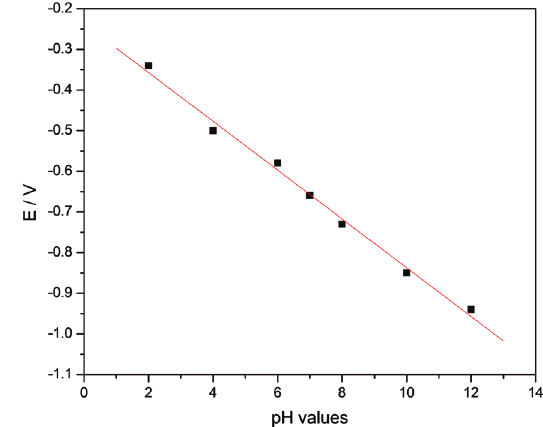
Figure 7. Potential range as a function of pH values for the WO